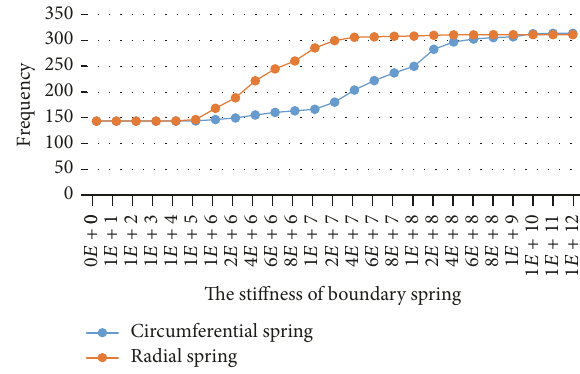
Figure 9: Natural frequency as a function of the stiffness of the radial and the circumferential linear